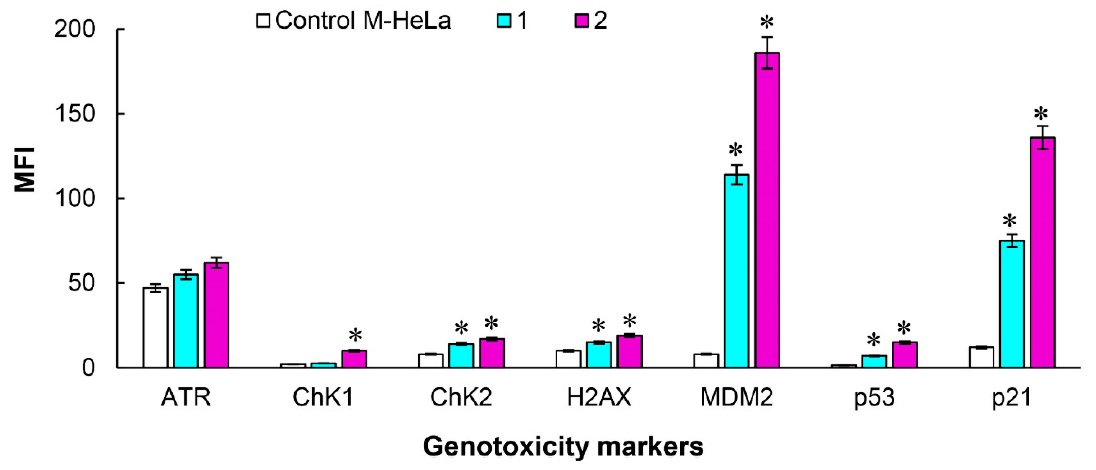
Figure 15. Multiplex analysis of markers DNA damage/genotoxicity in M-HeLa cells treated com- pound 7 . 1—at concentration IC 50 /2 (6 µ M); 2—at concentration IC 50 (12 µ M). M-HeLa cells untreated with the test substance (control). Data are presented as mean ± SD of three independent experiments * Values indicate p < 0.05.